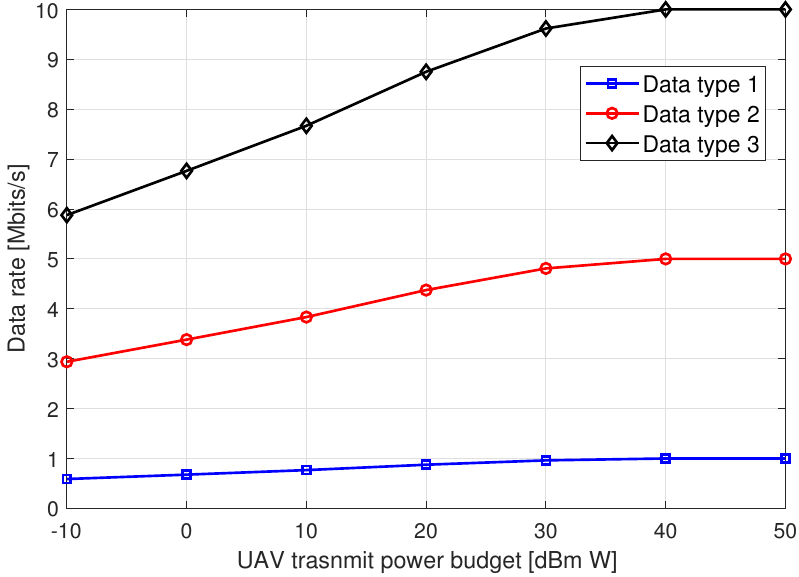
Figure 13. Average data rate attained in relation to UAS transmit power budget.